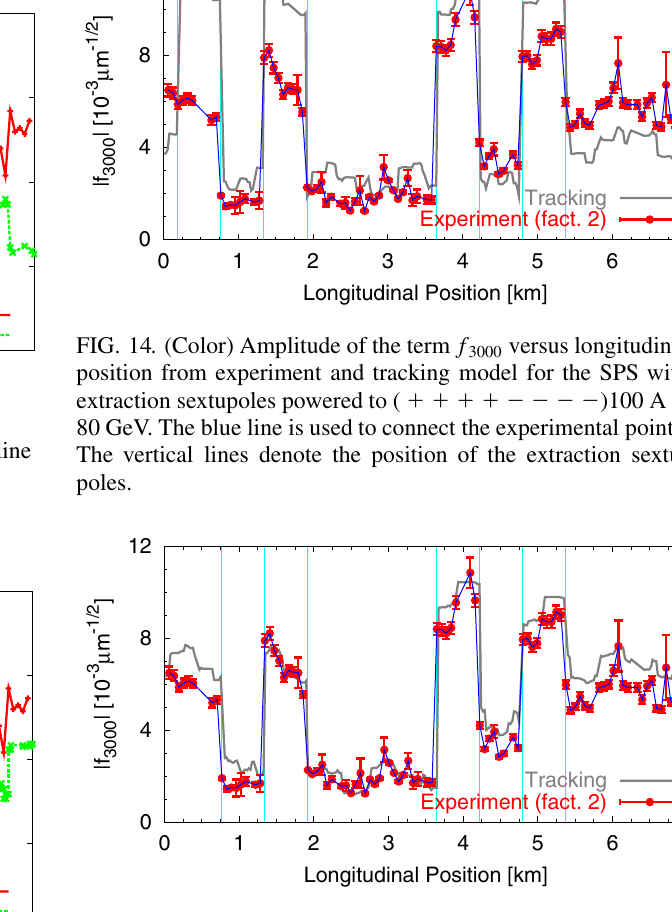
FIG. 15. (Color) Amplitude of the term f versus longitudinal 3000 position from experiment and tracking model for SPS with one sextupole disconnected ( (cid:5) (cid:5) (cid:5) (cid:1) (cid:1) (cid:1) (cid:1) ) 100 A at 80 GeV. The blue line is used to connect the experimental points. The vertical lines denote the position of the extraction sextupoles. Note that one sextupole with polarity ‘‘ (cid:5) ’’ is missing.